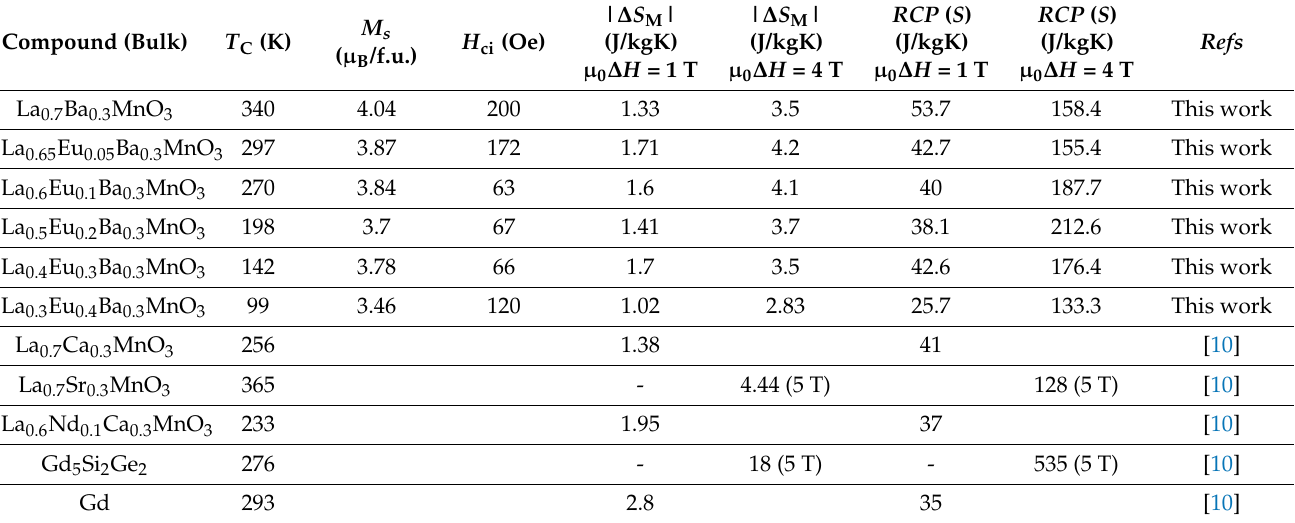
Table 6. Experimental values for La 0.7 − xEu x Ba 0.3 MnO 3 bulk materials: magnetic measurements.